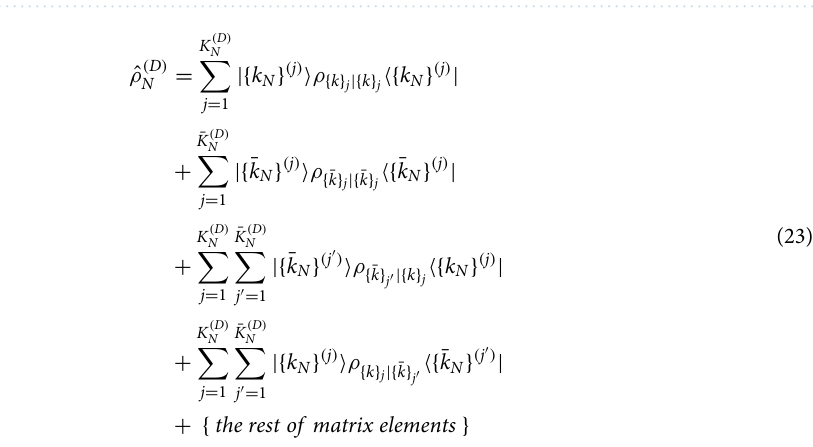
Figure 3. Schematic picture of the evolution of density matrix defined in D ⊗ quantum subsystems of D eigenstates each) in the separable case with respect to the local causality reversal (LCR-) procedure performed on m among N its subsystems ( m just a mapping of the Fig. 1 on the most general case where k n 1, 2, . . . N (instead of 1, 2 on Fig. 1), while m can be 1, 2, . . . N = that the meaning of all constituent blocks, arrows, etc. here is the same as for ones on Fig. 1. As well, the entire explanation of all the separable LCR scheme is qualitatively the same as one for Fig.